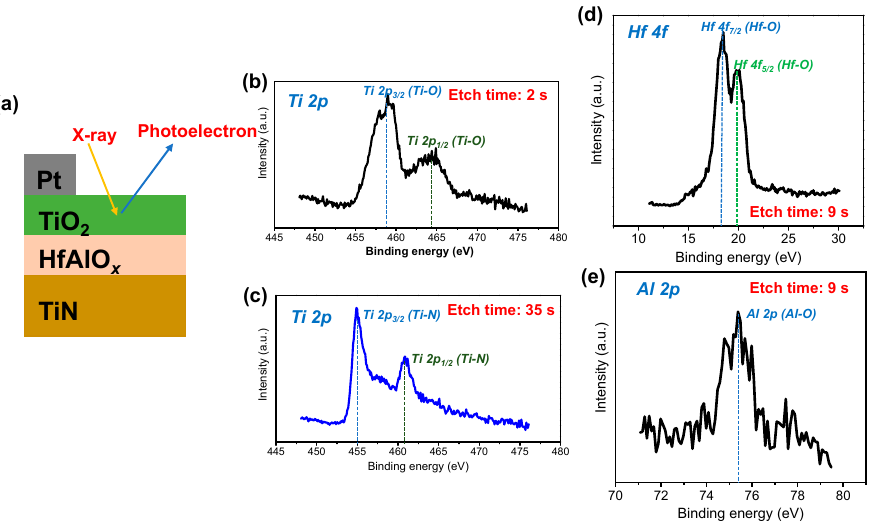
Figure 1. ( a ) Schematic of the Pt/TiO 2 /HfAlO x /TiN device. XPS spectra of the TiO 2 /HfAlO x /TiN stack: ( b ) Ti 1p for Ti-O bonds, ( c ) Ti 1p for Ti-N bonds, ( d ) Hf 4f, and ( e ) Al 2p spectra.